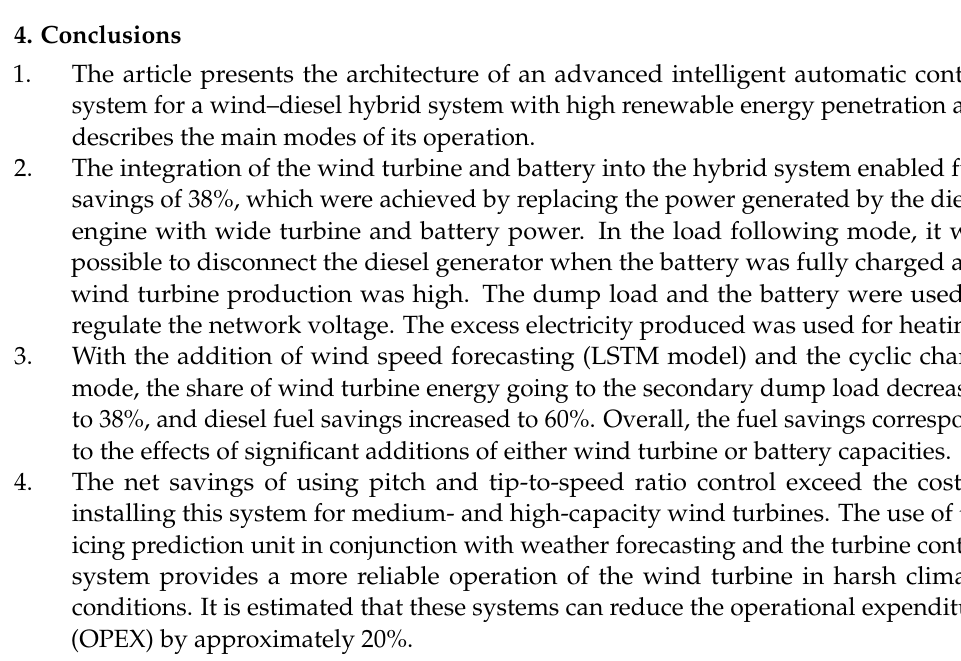
Figure 8. Wind turbine power curve under clean, icing, and optimized conditions.